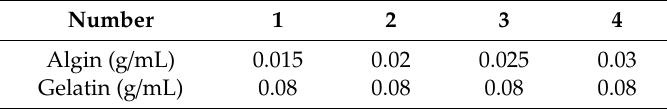
Table 2. Sample number of different concentration ratios.